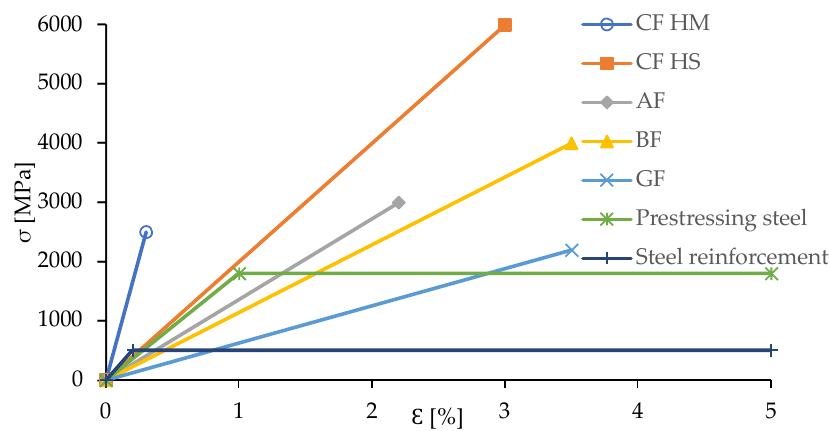
Figure 4 . Stress–strain characteristics for fibre materials and steel, adapted from [ 33 ]. Figure 4. Stress–strain characteristics for fibre materials and steel, adapted from